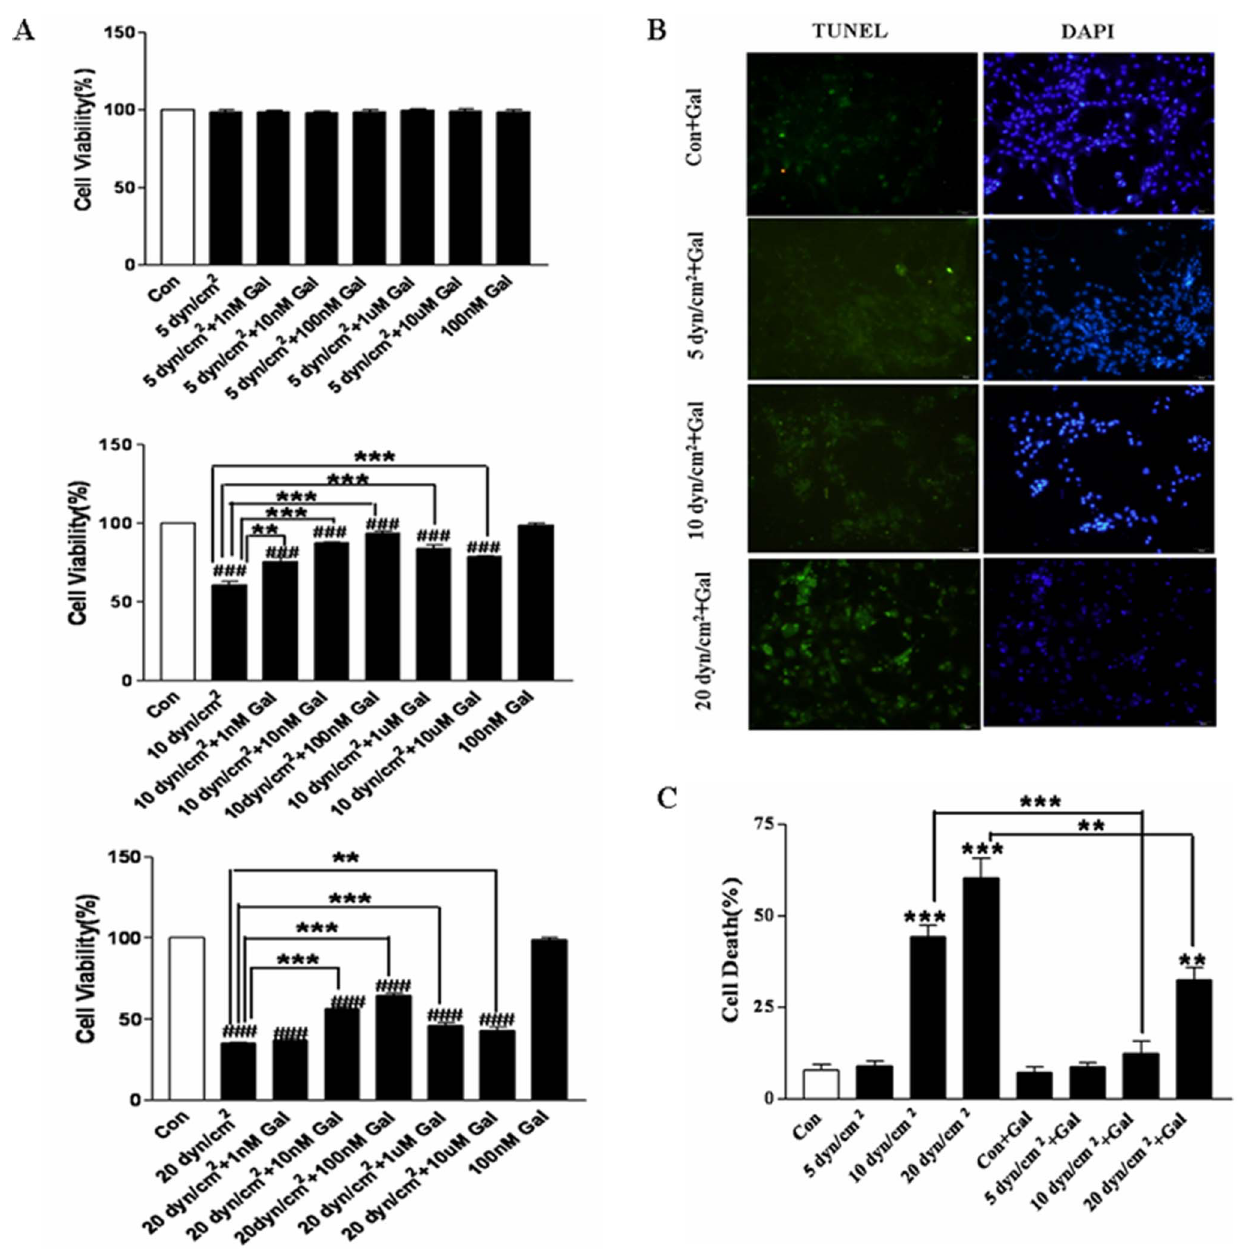
Figure 2. Influence of galanin on shear stress-induced neurotoxicity in primary cultured cortical neurons. A) Histograms show that pretreatment with galanin (Gal) at 1 m M, 100 nM, and 10 nM for 24 h counteracts the shear stress-induced decrease in cell viability, assessed by MTT assay at 10 dyn/cm 2 and 20 dyn/cm 2 . Cell viability does not change after shear stress of 5 dyn/cm 2 and there is no marked influence of 100 nM galanin alone on the cell viability. B) Photomicrographs and C) histograms show that pretreatment with 100 nM of galanin for 24 h reduces shear stress-induced nerve injury assessed by TUNEL assay. * p , 0.05, ** p , 0.01 and *** p , 0.001 were considered to be statistically significant (Scale bars: B, 50 m m)